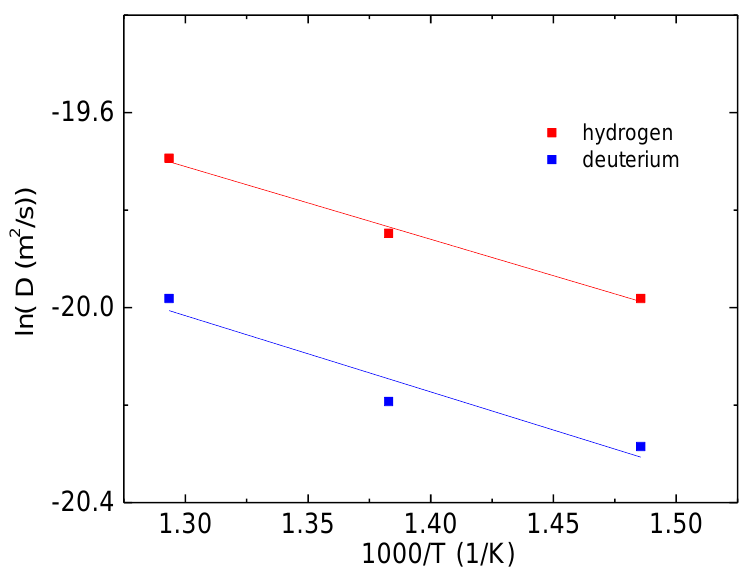
Figure 5. Dependence of the logarithm of the calculated diffusion coefficient of Ni 33 Ti 39 Nb 28 from the inverse of the absolute temperature and best fit lines.